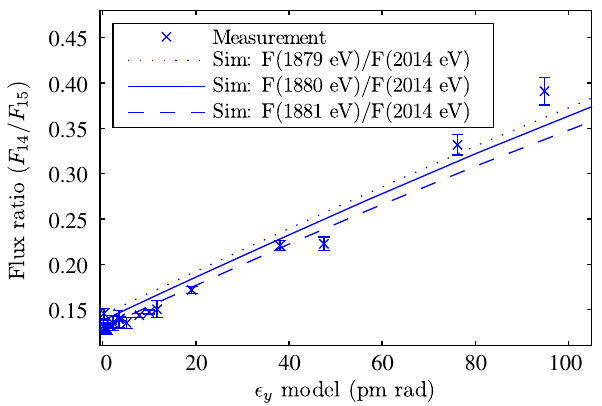
FIG. 5. Measured pinhole photon flux, fitted for orbit bumps through the undulator. Storage ring skew quadrupoles were configured for minimum vertical emittance ð ε y < 1 pm rad Þ . Photon energies correspond to undulator harmonics n ¼ 13 , 14, and 15 [30].